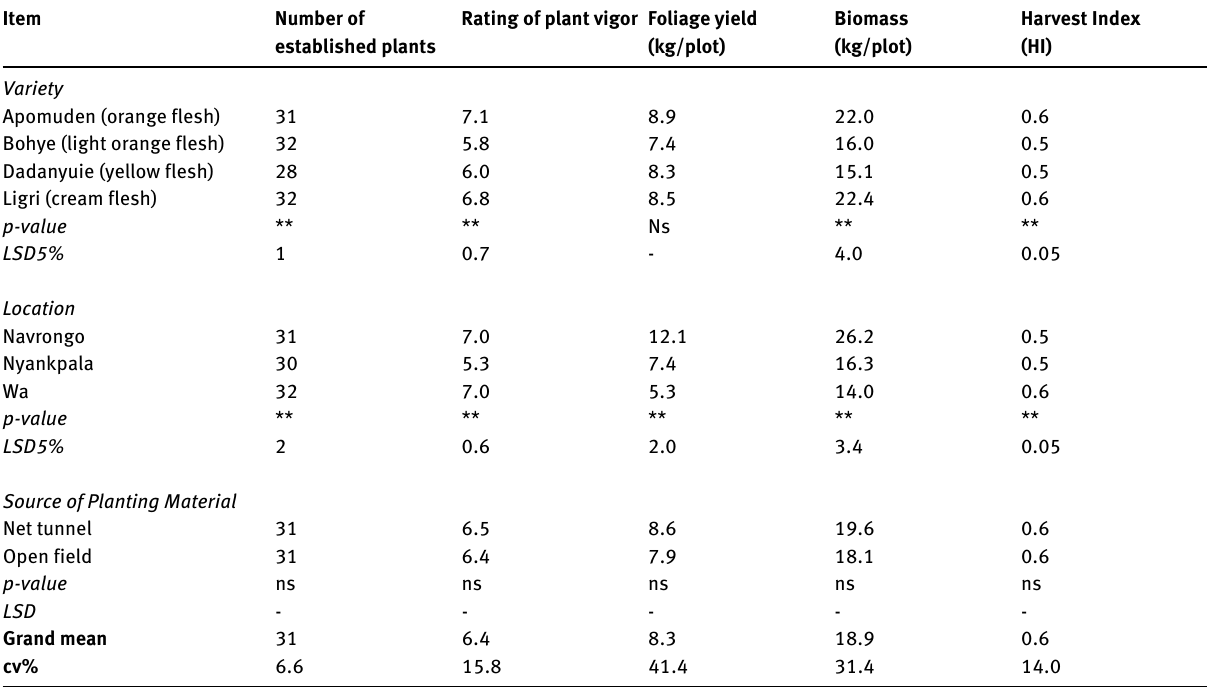
Table 2: Number of plant establishment, rating of plant vigor, foliage yield, biomass and harvest index (HI) Item